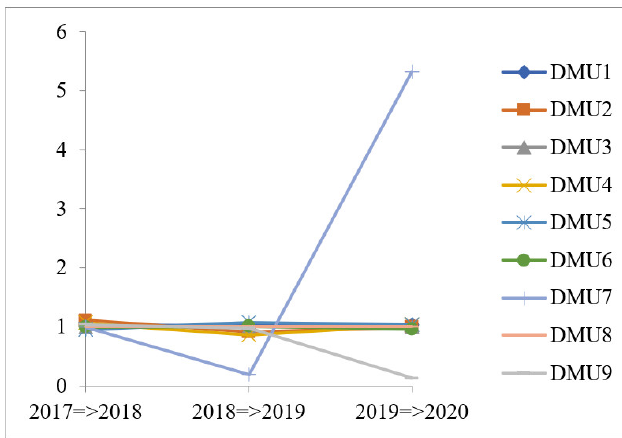
Figure 3. Technical efficiency change in DMUs (catch-up index) .